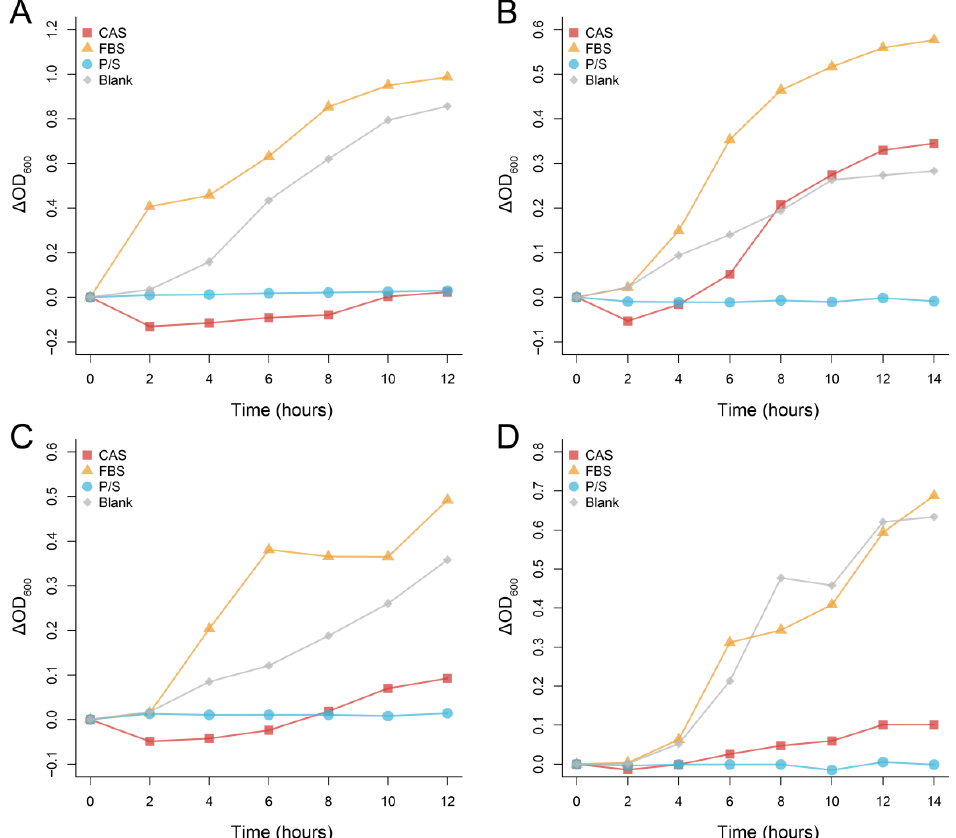
Figure 2. Antibacterial effect of Chinese alligator serum on Klebsiella pneumoniae ( A ), Staphylococcus aureus ( B ), Escherichia coli ( C ), and Pseudomonas aeruginosa ( D ) at a given concentration. Changes in absorbance were obtained by comparing the absorbance of each sample at different times with the initial absorbance. CAS: Chinese alligator serum, FBS: fetal bovine serum, P/S: Penicillin- Streptomycin Solution.